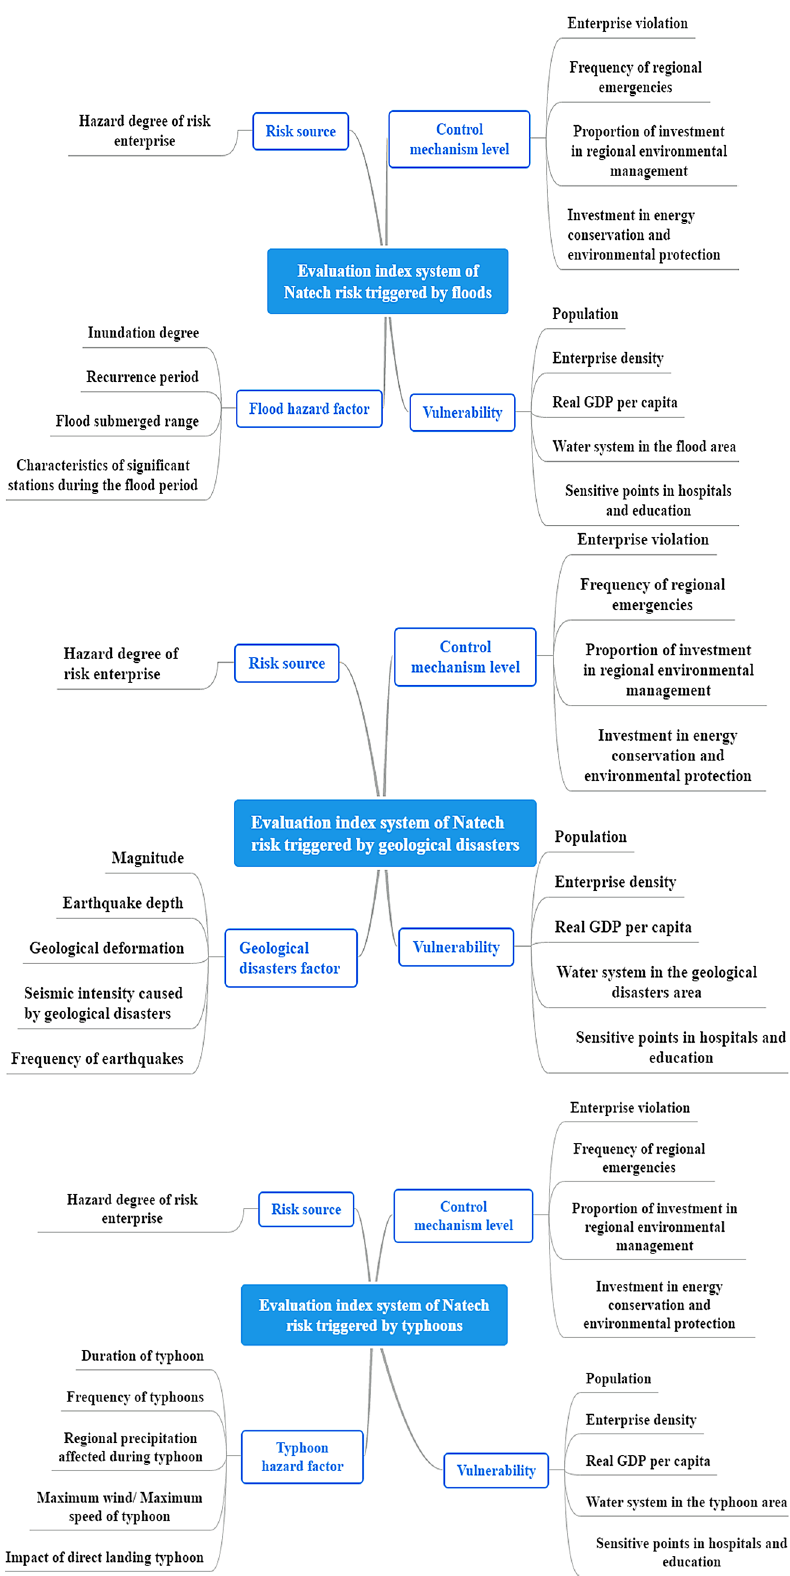
Figure 2. The evaluation index system of Natech risk in the